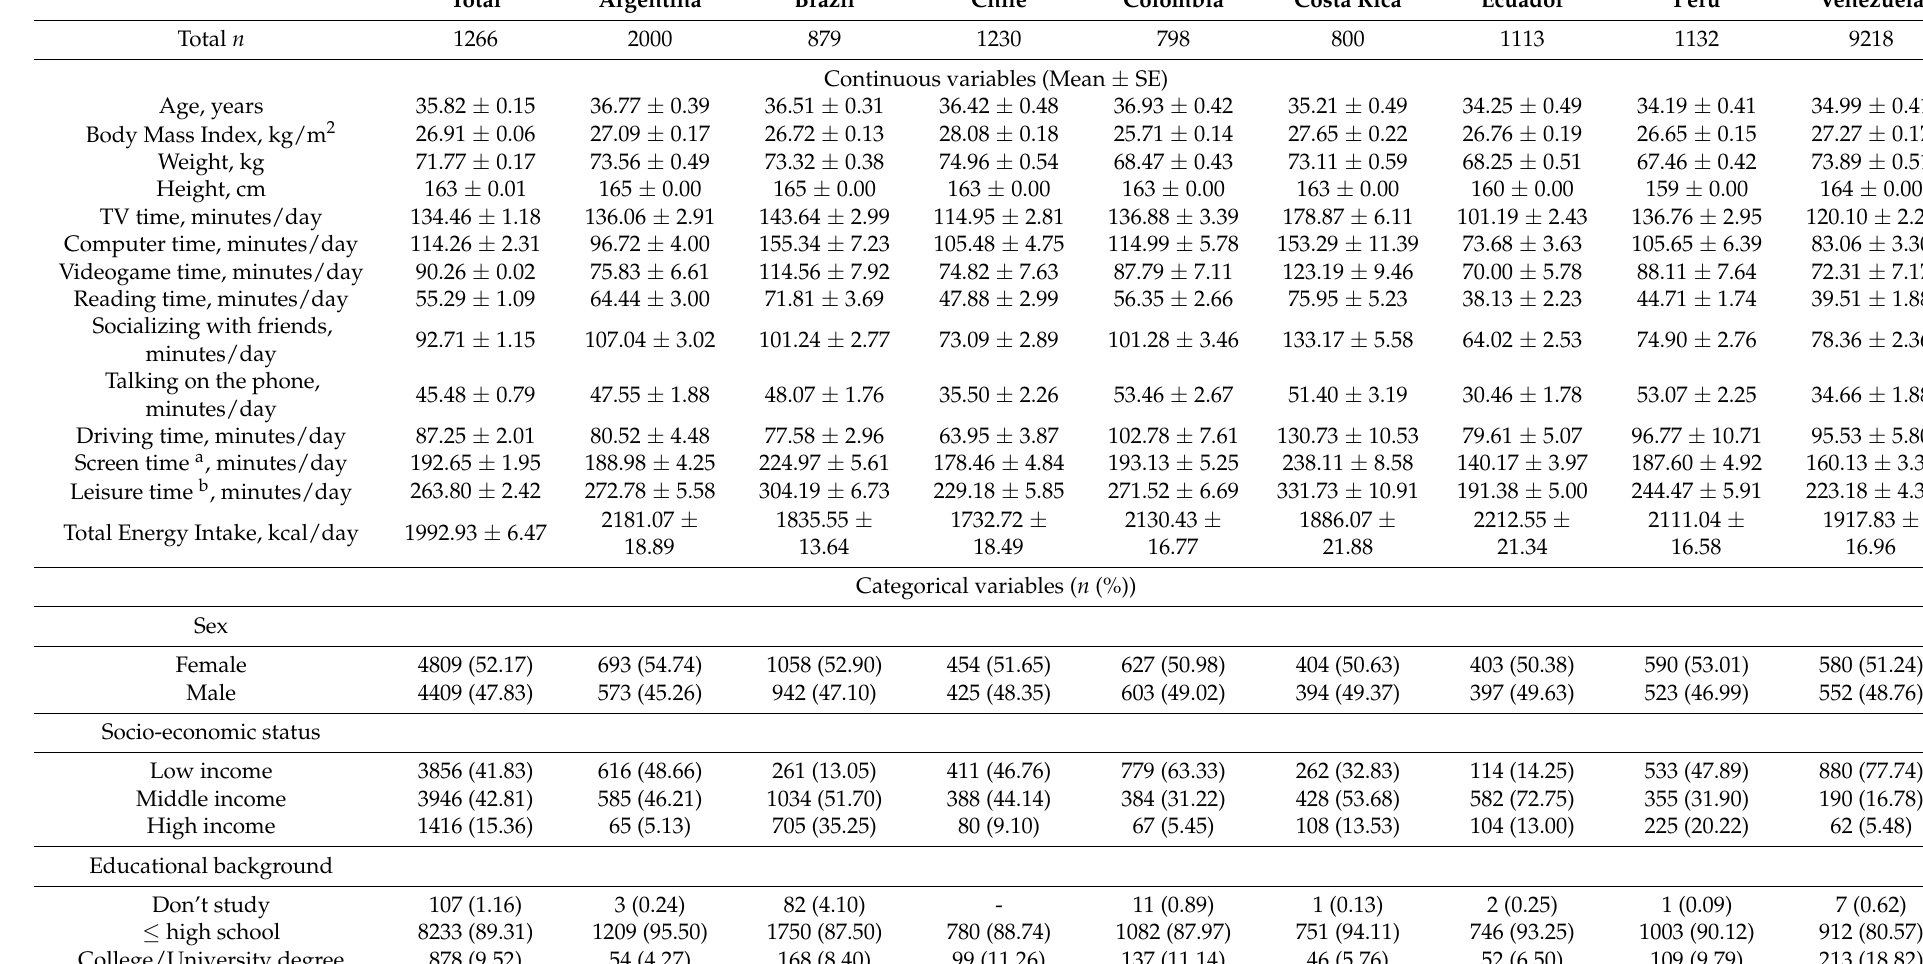
Table 1. Socio-demographics and lifestyle characteristics of the study sample: The Latin American Study of Nutrition and Health (ELANS) ( n = 9.218).